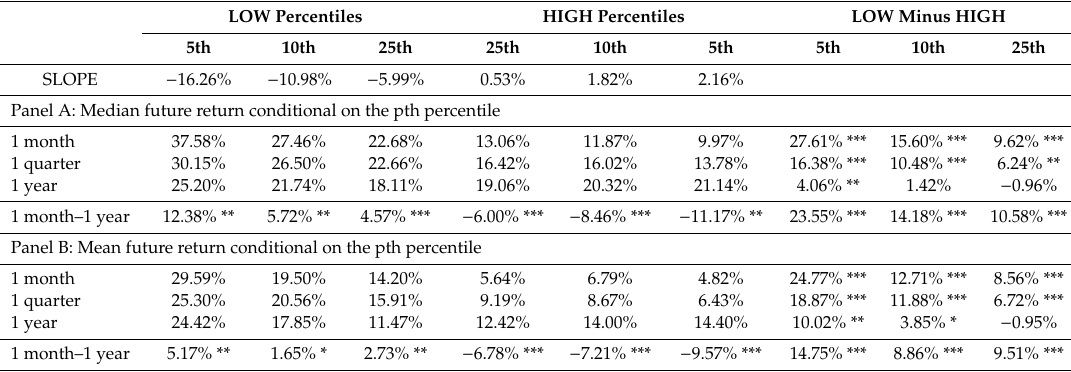
Table 3. Results from tests of the SLOPE and STEEPNESS